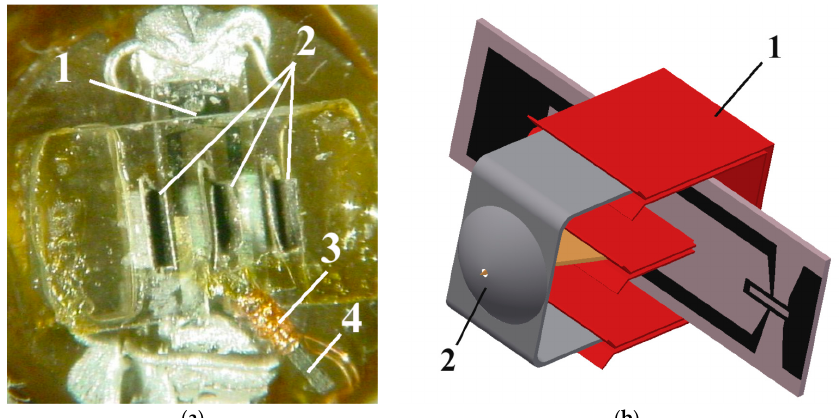
Figure 7. ( a ) Photograph of a high-T c DC SQUID (1) assembled on a sapphire rod, showing parts of the magnetic flux antenna (2) and the modulation coil (3) on ferromagnetic wires (4); ( b ) Sketch of a DC SQUID with a directly coupled pick-up loop assembled together with low temperature (1) and room temperature (2) parts of the flux antenna.